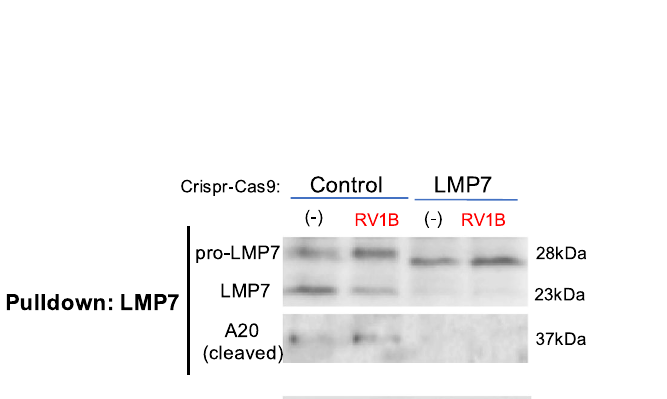
Figure 7. A20 inhibits RV-mediated inflammation in human tracheobronchial epithelial (HTBE) cells . HTBE cells (n = 3 donors) in submerged culture transfected with A20 siRNA or Scrambled control (Scr) siRNA were infected with RV1B at 5 × 10 4 PFU/well or with 0.1% BSA-PBS (−) for 48h. ( A ) Representative western blot image and densitometry of A20 protein (90 kDa). ( B ) IL-8 and ( C ) IP-10 levels in the supernatant were normalized to total protein in the cell lysate. Horizontal bar represents mean. Data were analyzed using Student’s